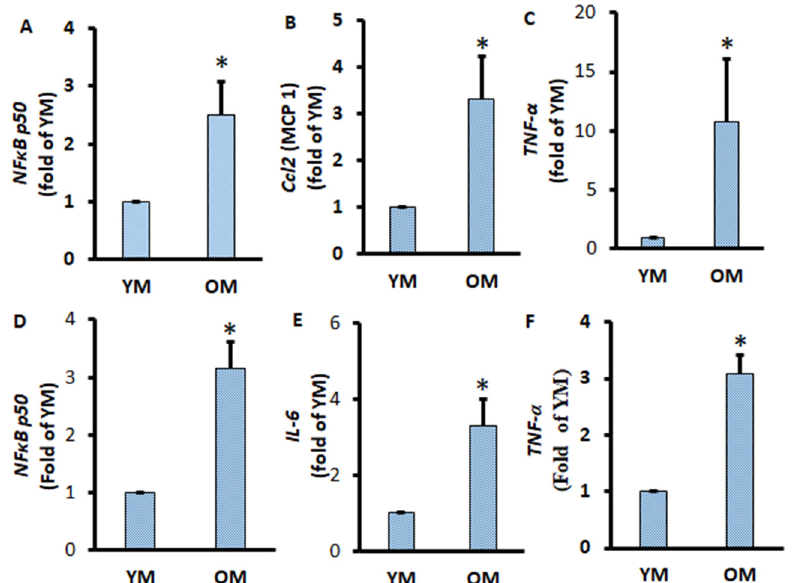
Figure 5. Pro-inflammatory gene expressions of EWATs and adipocytes of aged mice. EWATs were collected from YM and OM mice. The mRNA expressions of NF- κ B p50 ( A ), Ccl2 ( B ), and TNF- α ( C ) were measured by RT-qPCR and normalized by GPDH and EEF2. Adipocytes were isolated from EWATs, and the mRNA expressions of NF- κ B p50 ( D ), IL-6 ( E ), and TNF- α ( F ) were measured by RT-qPCR and normalized by GAPDH and EEF2. Data were analyzed using t -test; * p < 0.05 compared to YM.